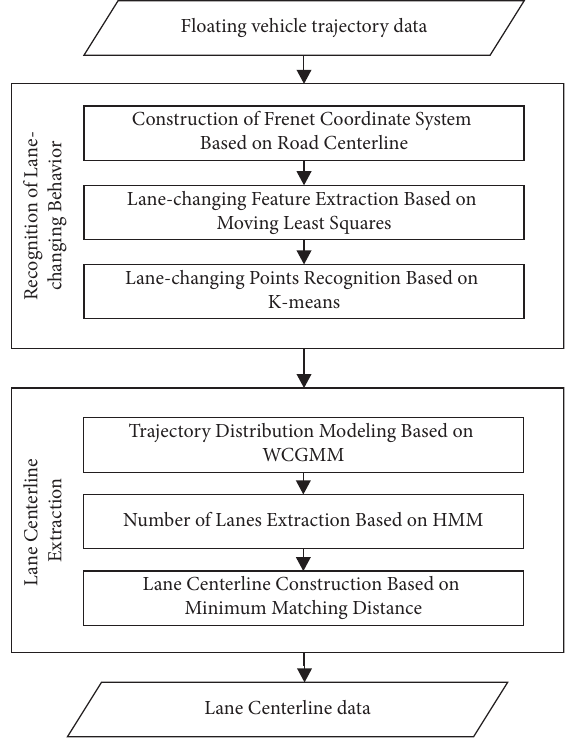
Figure 1: Flowchart of lane information